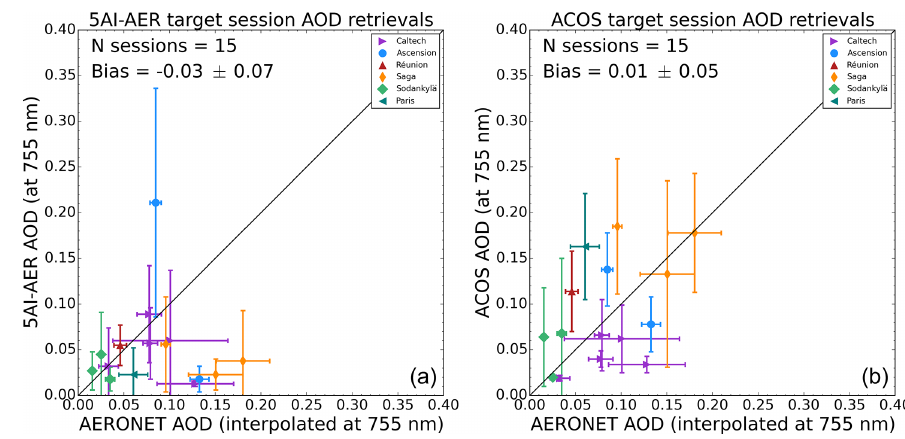
Figure 10. The 5AI-AER (a) and ACOS B8r (b) OCO-2 target total AOD retrieval results compared to AERONET AOD interpolated at 755nm. Individual sounding results are averaged for every target session. Markers show the session average for OCO-2 and AERONET AOD, and error bars show the standard